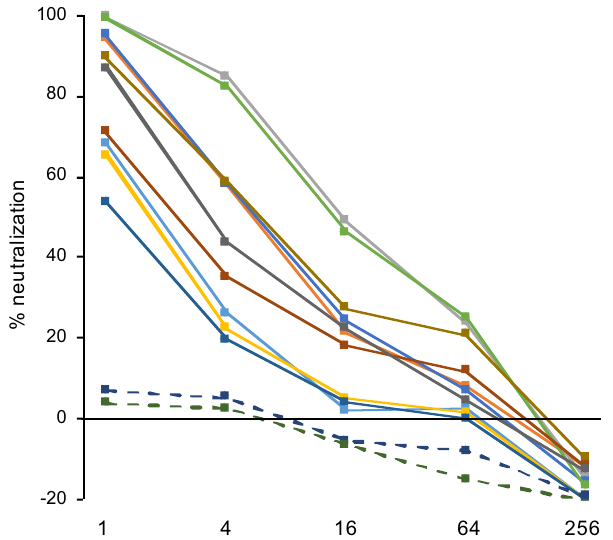
Figure 1. Neutralization of SARS-CoV-2 Spike-ACE2 interaction in DBS samples from convalescent COVID- 19 cases and pre-pandemic negative samples. Reduction in neutralization with dilution of 12 DBS samples (1:4, 1:16, 1:64, 1:256) after initial elution of one 5 mm punch in 100 μL assay buffer. Negative samples are indicated with dashed lines.